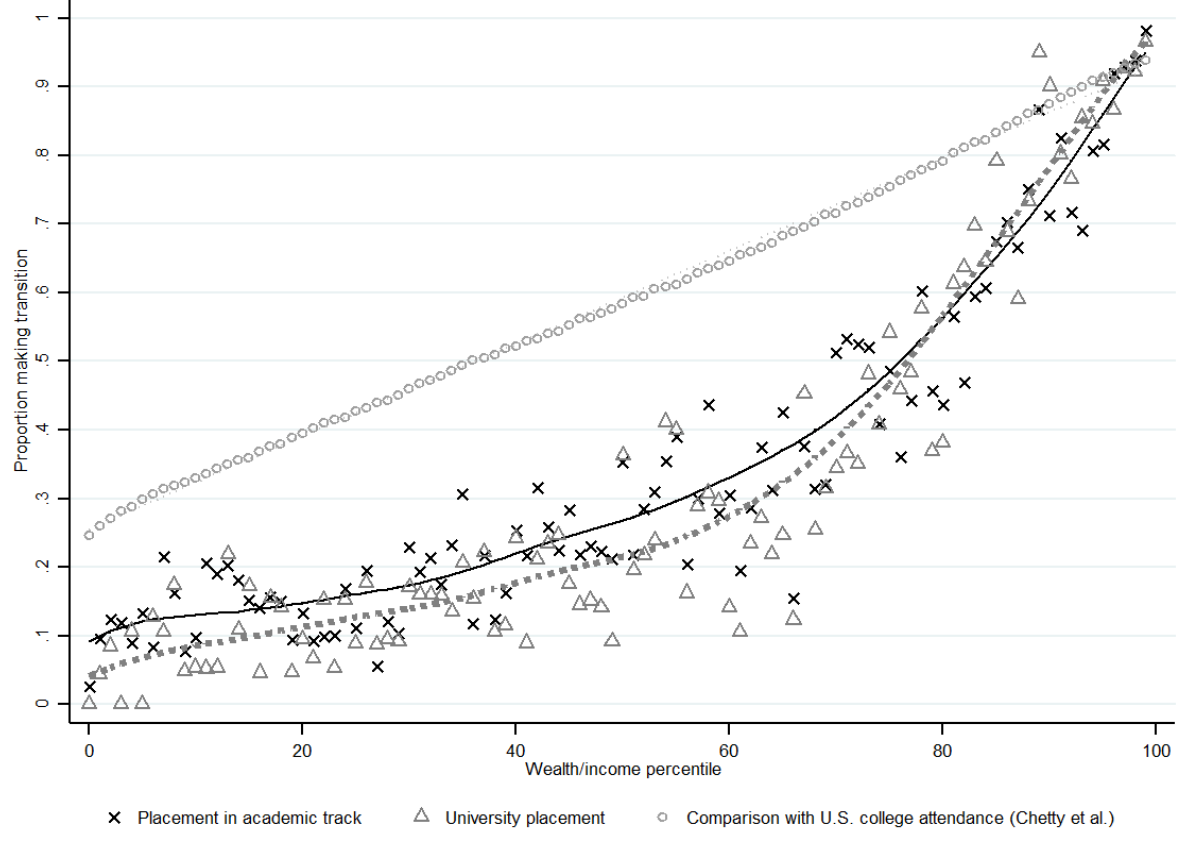
Figure 1: Mean proportion of students* placed in upper-secondary academic track and making the transition to four-year college (unconditional) for each wealth/income